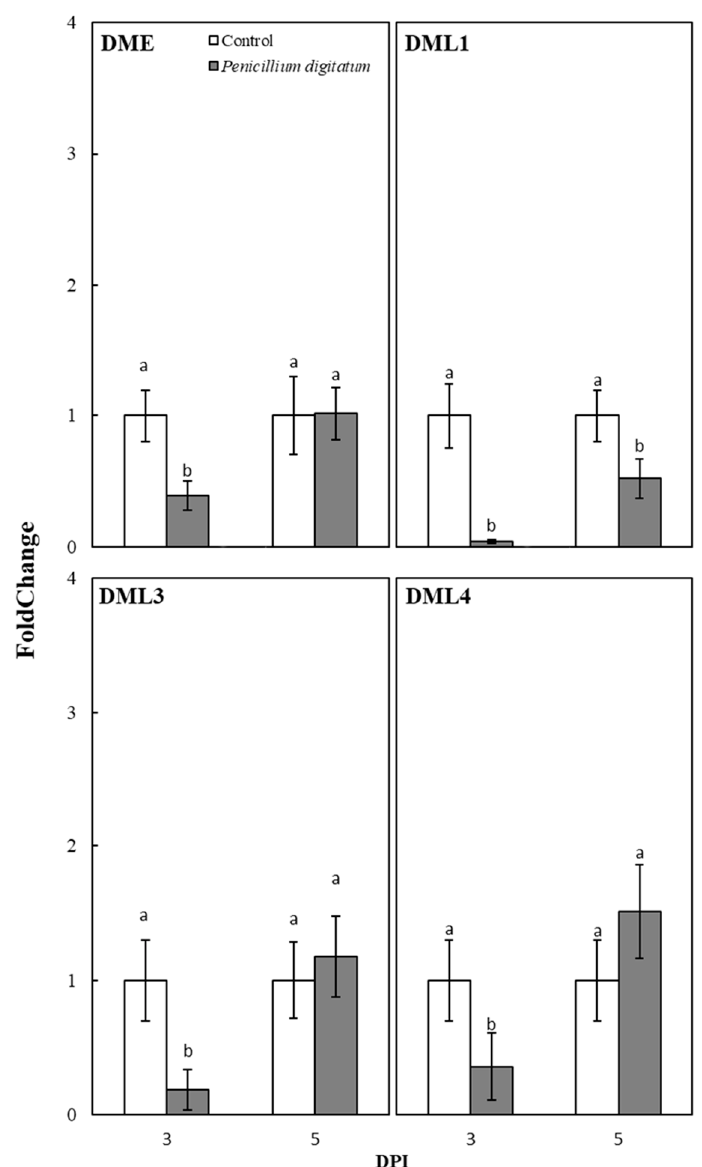
Figure 5. Expression pattern of demethylase encoding genes DME, DML1, DML3, and DML4 in both inoculated and control plants. Each bar represents the mean value of three replications ± SD. Significantly different values, within each sampling time, are indicated by different letters ( p < 0.05).